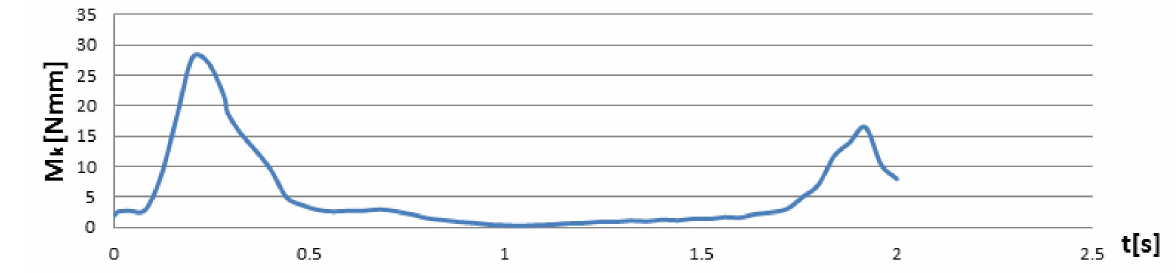
Figure 18. Torque graph for the HS-82MG